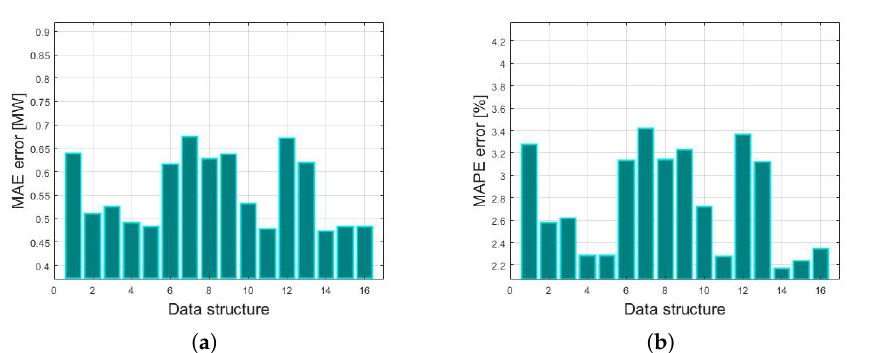
Figure 19. Summary of forecast accuracies by the selected data structure for wind power plant FW1. ( a ) MAE. ( b )